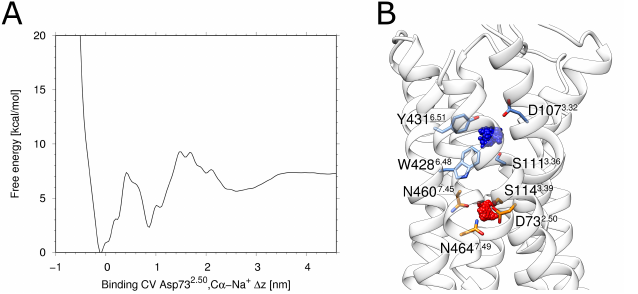
Figure 2. Metadynamics of the sodium ion. ( A ) Energy landscape obtained from the multiple walker metadynamics approach for H 1 R. Two distinct primary minima and one broader less-defined minimum can be seen. Panel ( B ) depicts the associated clusters. The most populated and therefore the lowest energy state is depicted in red, while the blue cluster represents the second distinct minimum from ( A